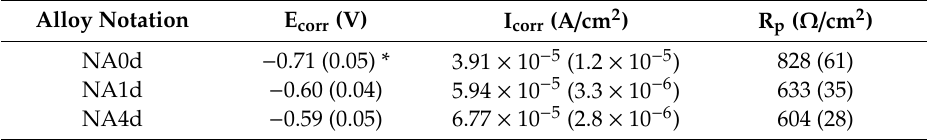
Figure 2. Polarization curves of different naturally aged A201-T7 alloys in a 3.5% NaCl solution. Table 5. Parameters of polarization test of different naturally aged A201-T7 alloys in a 3.5% NaCl solution .